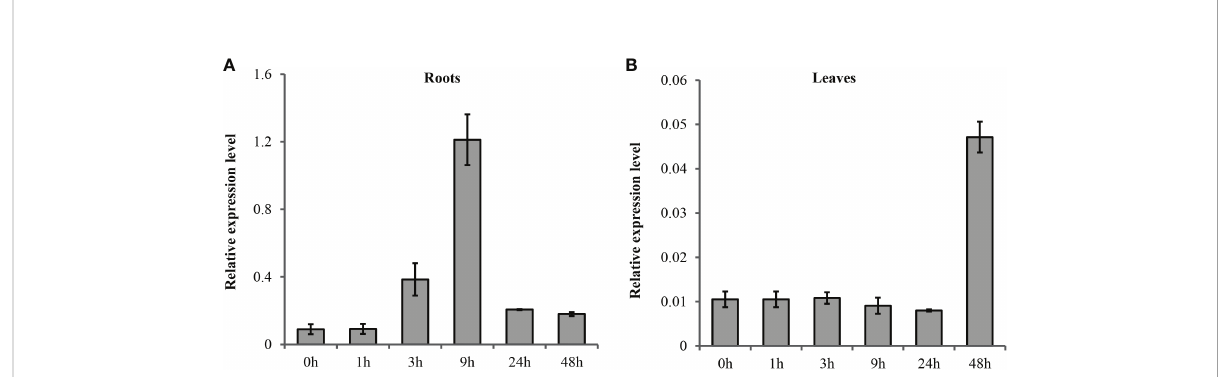
FIGURE 2 Quantitative RT-PCR analysis of the expression of TaSOS1 genes in response to salt stress in wheat. Transcript levels of TaSOS1 genes detected in 7-day-old wheat seedling roots (A) and leaves (B) were subjected to 0 mM or 200 mM NaCl treatment with indicated time course. The expression of b -Actin was used as an endogenous control. Error bars represent the standard deviations of three technical replicates, and the results were consistent in three biological